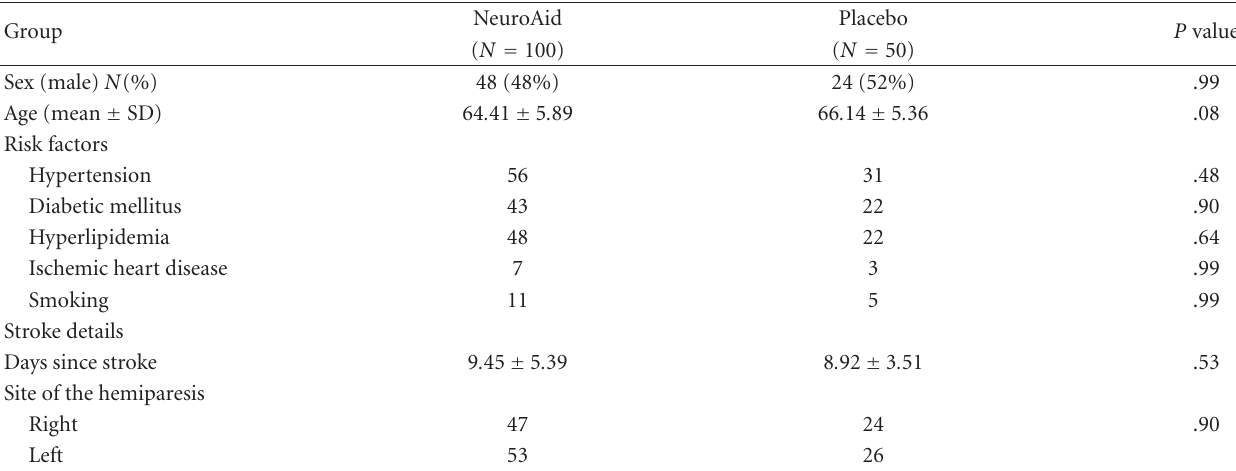
Table 1: Baseline characteristics of two groups.